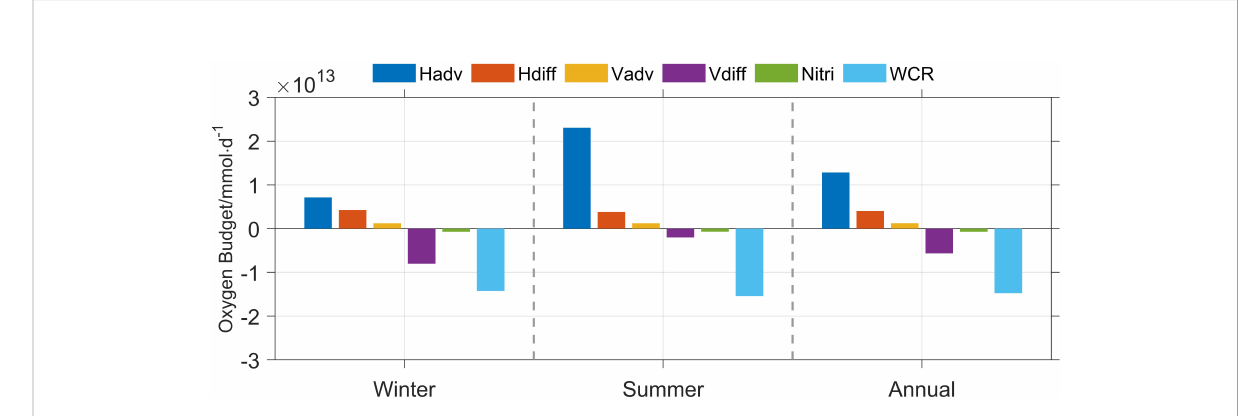
FIGURE 4 Modeled oxygen budget of dissolved oxygen concentration for intermediate water column (200 – 1,000 m) in the Arabian Sea Oxygen Minimum Zone. Abbreviations in the legend are for horizontal advection (Hadv), vertical advection (Vadv), horizontal diffusion (Hdiff), vertical diffusion (Vdiff), nitri fi cation (Nitri), and water column respiration (WCR). Note that the positive value in the budget represents a net gain of dissolved oxygen while the negative value represents a net